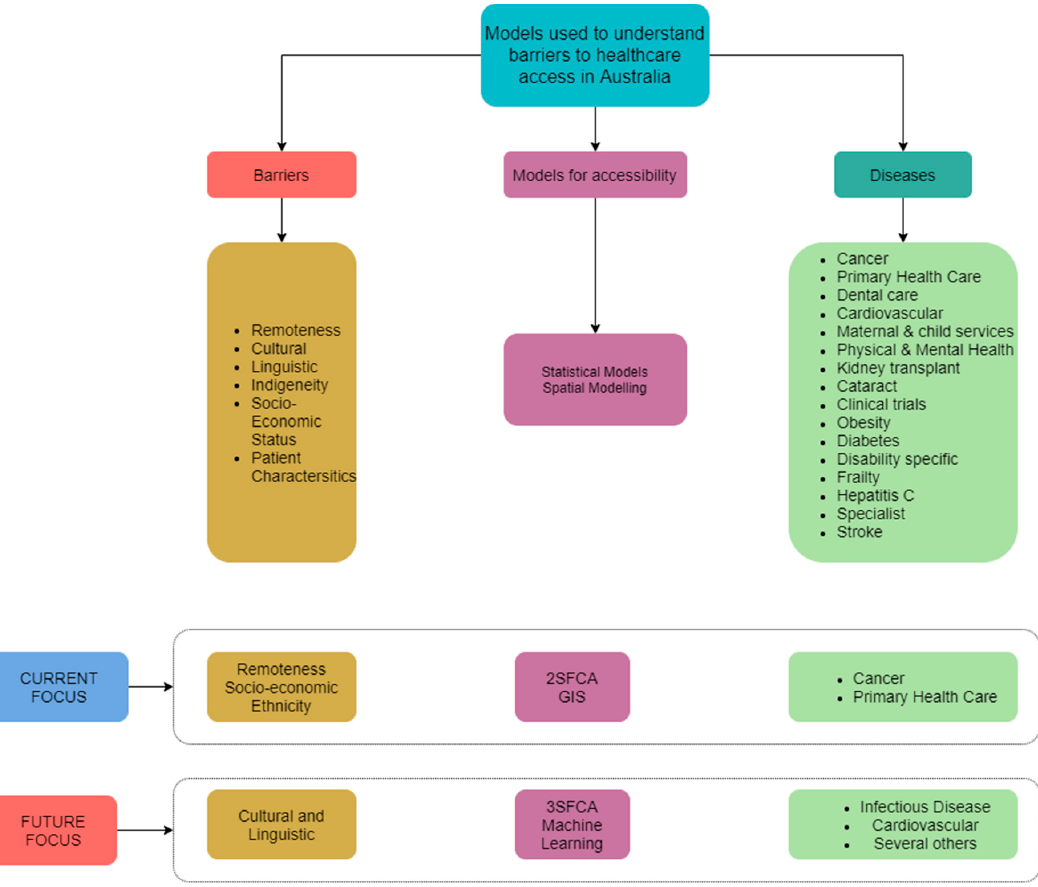
Figure 6. Flowchart of the present study and future directions.